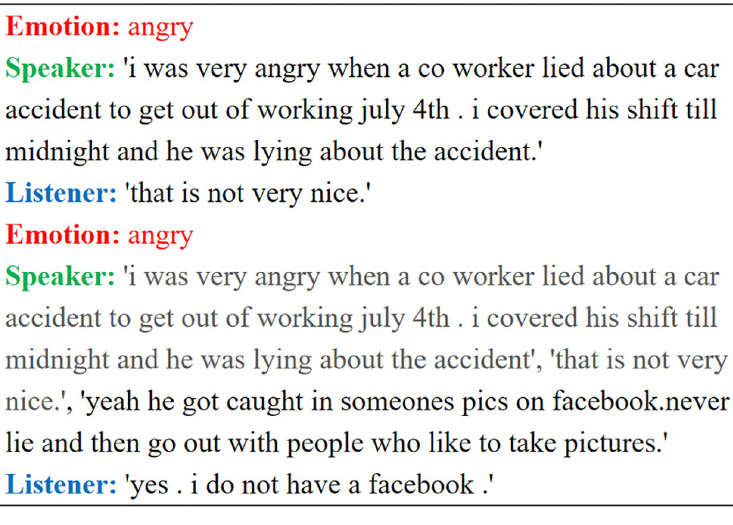
Fig 6. A sample of the Empathetic Dialogue